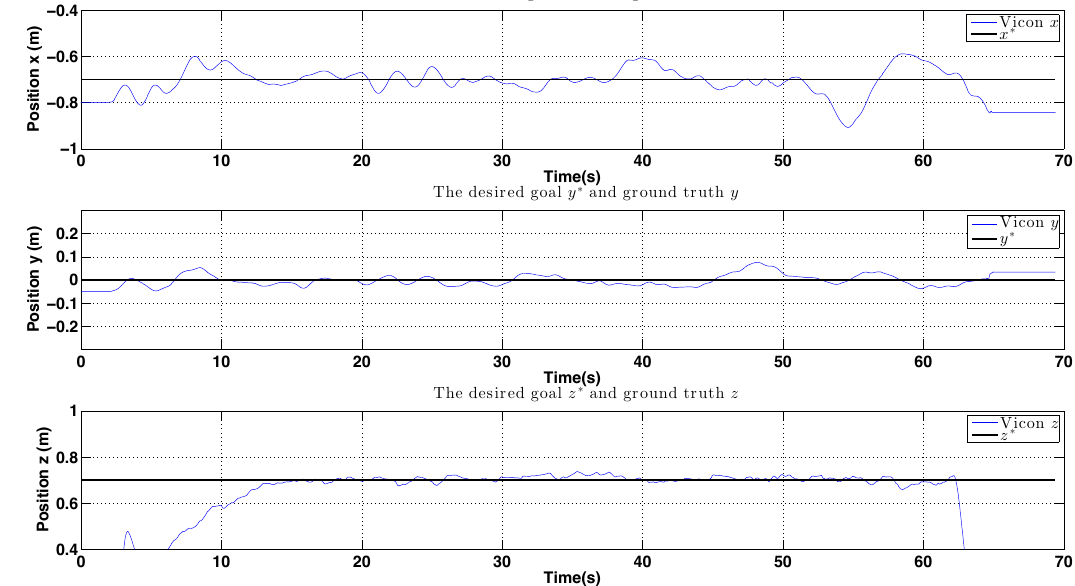
Figure 23. Experimental results for PBVS-based indoor hovering: control performance. Goal (black) and ground truth states (blue). The desired position for W ˆ x , W ˆ y and W ˆ z is 0.7 m , 0 m and 0.7 m . We compute standard deviation of errors for each state over the − interval 15 s 63 s: σ = 0.048 m , σ = 0.024 m , and σ = 0.011 m x y z ∼